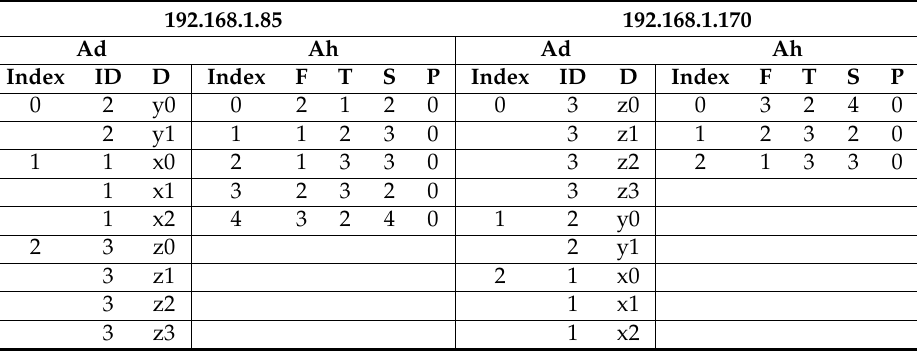
Table 4. Data transference between Ro 2 and Ro 3